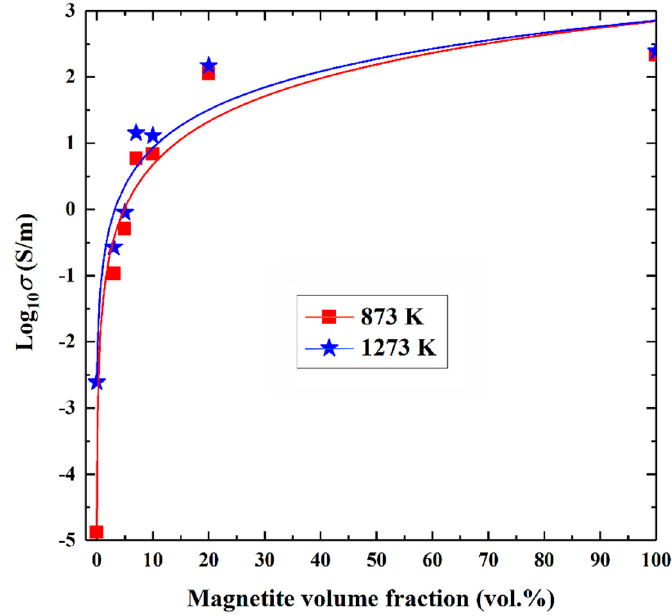
Figure 9. Influence of the magnetite volume fraction on the electrical conductivity of olivine aggregates. Electrical conductivities were obtained under two experimental boundary temperature conditions (873 K and 1273 K) at 2.0 GPa.